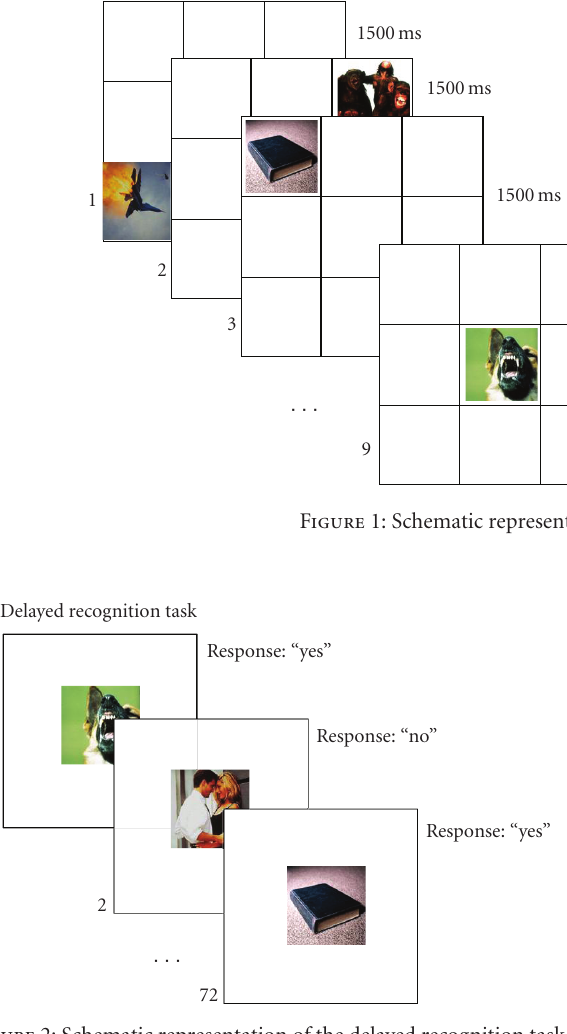
Figure 2: Schematic representation of the delayed recognition task.